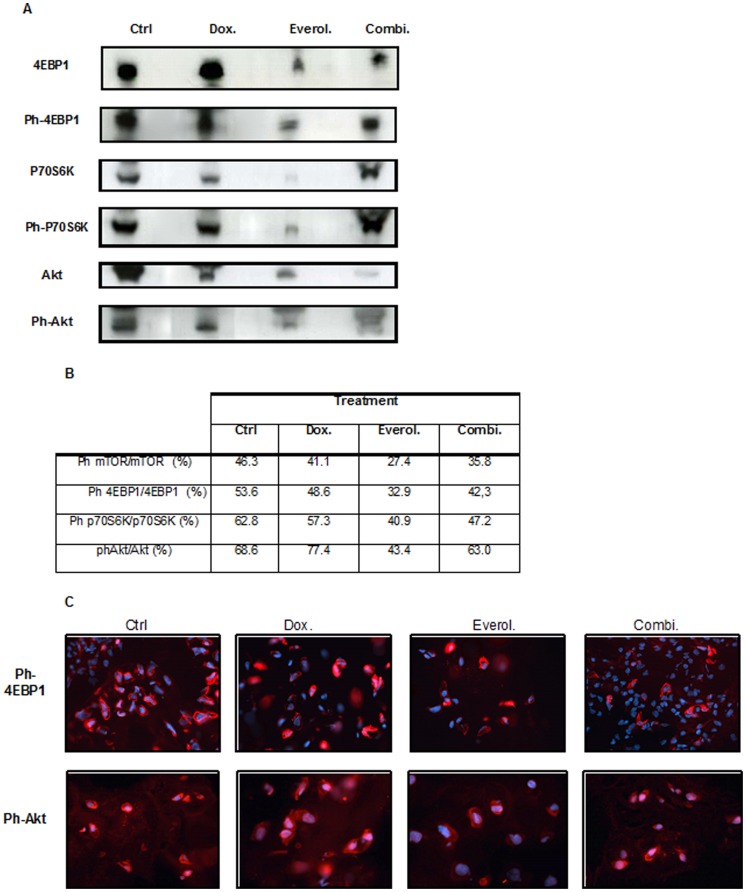
Assessment of mTOR pathway inhibition in everolimus-treated tumors.A, a decrease in the expression of phospho-4EBP1 and phospho-p70S6K1 was observed after treatment with everolimus showing the inhibition of mTOR pathway. Such a decrease was not obtained in the Doxorubicin treated tumors. The expression of ph-Akt was not altered by treatment. B: inhibition of mTOR and its downststream effectors activation after everolimus treatment was confirmed by a decrease of the ratio phosphorylated/total proteins (mTOR 4EBP1, p70S6K1, Akt). C, immunofluorescent staining of ph-4EBP1 and ph-Akt confirmed the Western blot analysis. A strong decrease in ph-4EBP1 staining was seen in tumors from the everolimus treated groups (either as single agent or combination treatment). Neither of the treatments induced changes in the expression of ph-Akt.